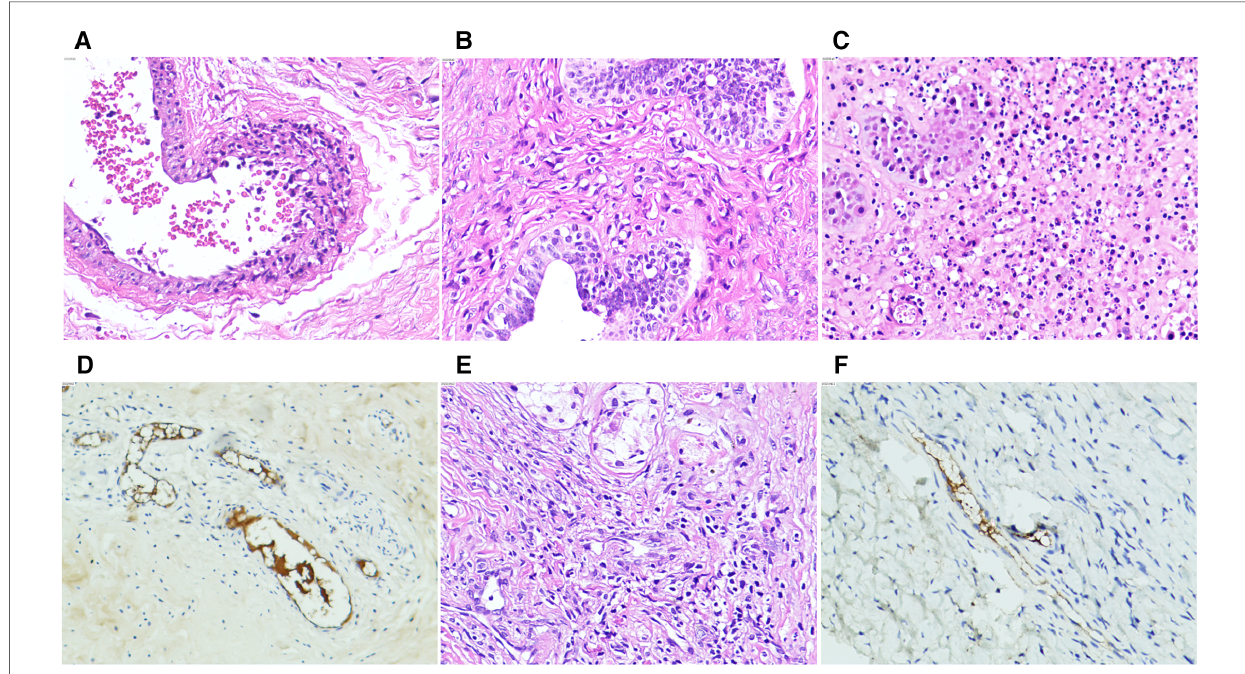
FIGURE 2 Photomicrographs of immunoglobulin A vasculitis with testicular/epididymal involvement. ( A – D ) A four-year-old patient underwent orchiectomy for complete right testicular infarction. ( A ) Neutrophil in fi ltration with localized necrosis is shown in the vascular wall of the spermatic cord (hematoxylin and eosin (H&E, ×20). ( B ) Lymphocytic in fi ltration is shown in the wall of the vas deferens (H&E, ×20). ( C ) Most of the germinal tubules are necrotic with neutrophil, lymphocyte, and monocyte in fi ltration (H&E, ×20). ( D ) Immunohistochemical stains showing immunoglobulin A immune complex deposits are observed in the vascular walls of the epididymis and testicular interstitium at several sites. ( E,F ) Partial infarction of the right testicle of a six-year-old patient is shown. ( E ) HE staining shows the testicular parenchyma and interstitial necrosis with lymphocytic in fi ltration in the vessel wall (×20). ( F ) Immunohistochemical staining shows immunoglobulin A immune complex deposition in the vascular wall of the testicular tissue